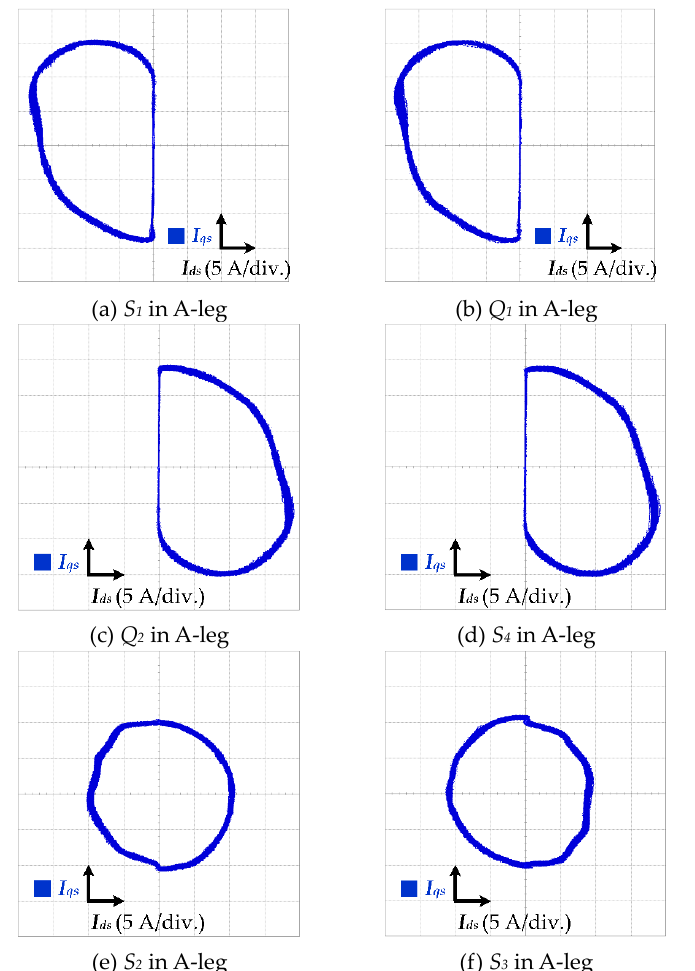
Figure 13. Measured current patterns according to faulty condition.